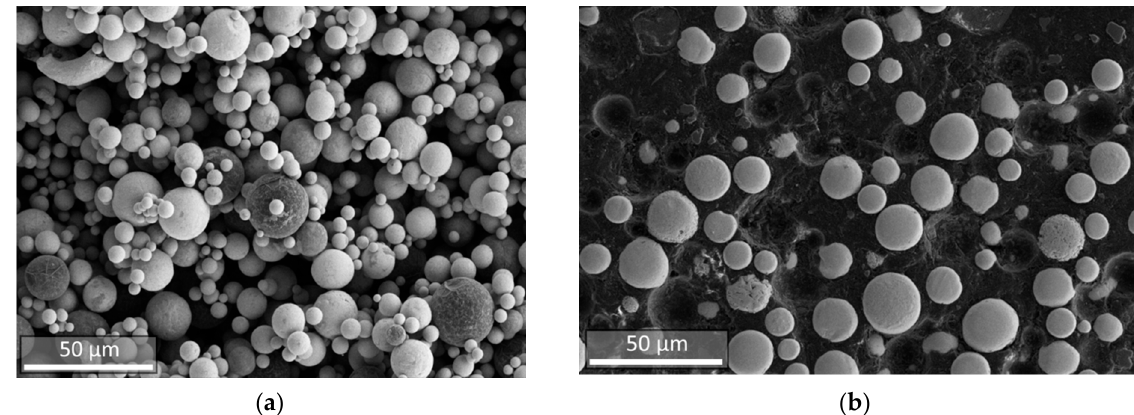
Figure 6. SEM images of W-C-Co micropowder after the spheroidization and removal of nano- and submicron particles ( a ) and metallographic cross-section of this powder ( b ). Table 1. Characteristics of W-C-Co